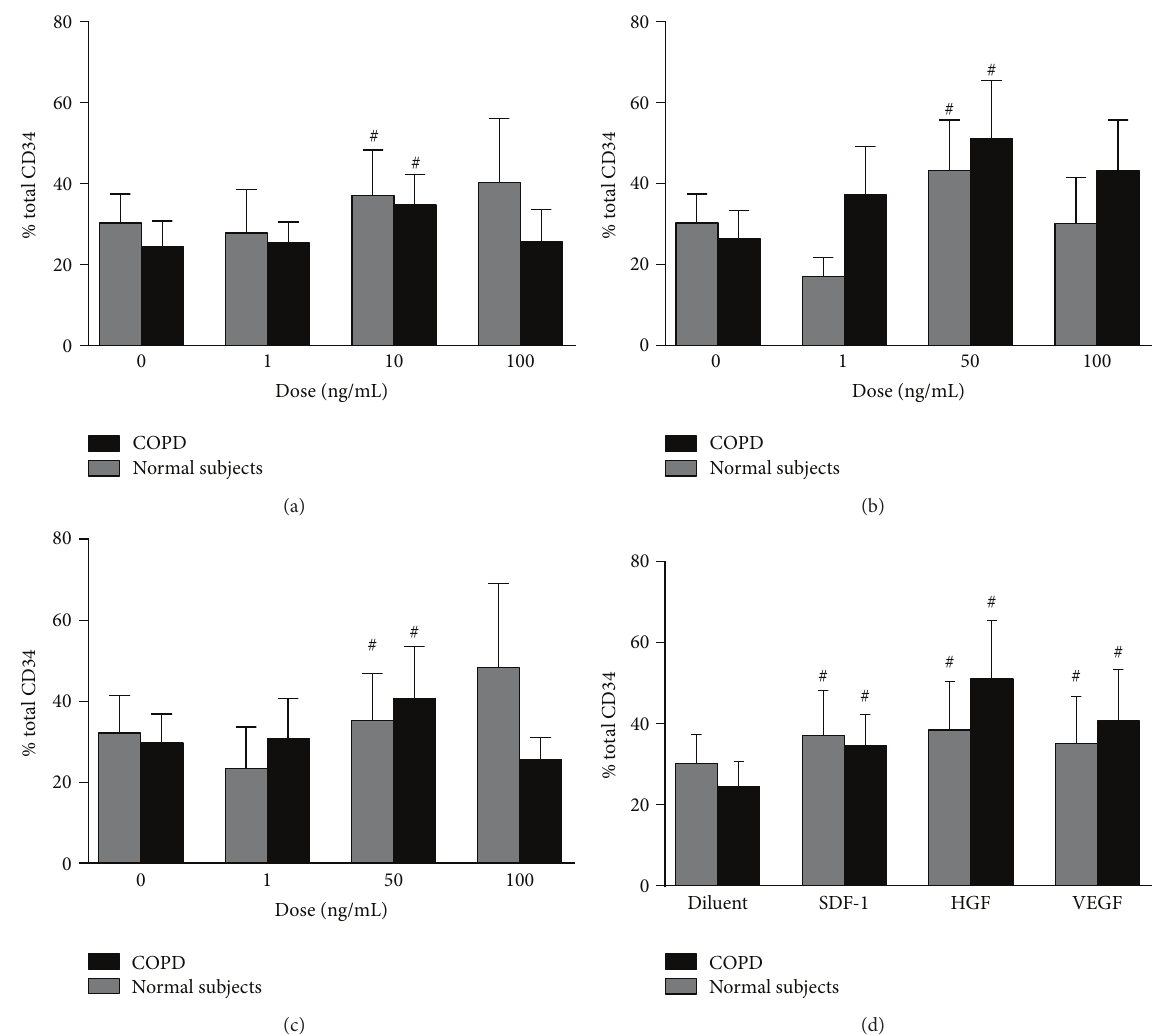
Figure 4: Enumeration of adhesion to fibronectin of blood HPC from COPD and normal subjects to (a) SDF-1 𝛼 , (b) HGF, and (c) VEGF. (d) Comparison of the optimal adhesive response to SDF-1 𝛼 (10ng/mL), HGF, and VEGF (both 50 ng/mL) shows no significant difference between the two groups of subjects. Data are presented as mean ± SEM ( 𝑛 = 6 ); # 𝑝 < 0.05 within group comparisons to diluent